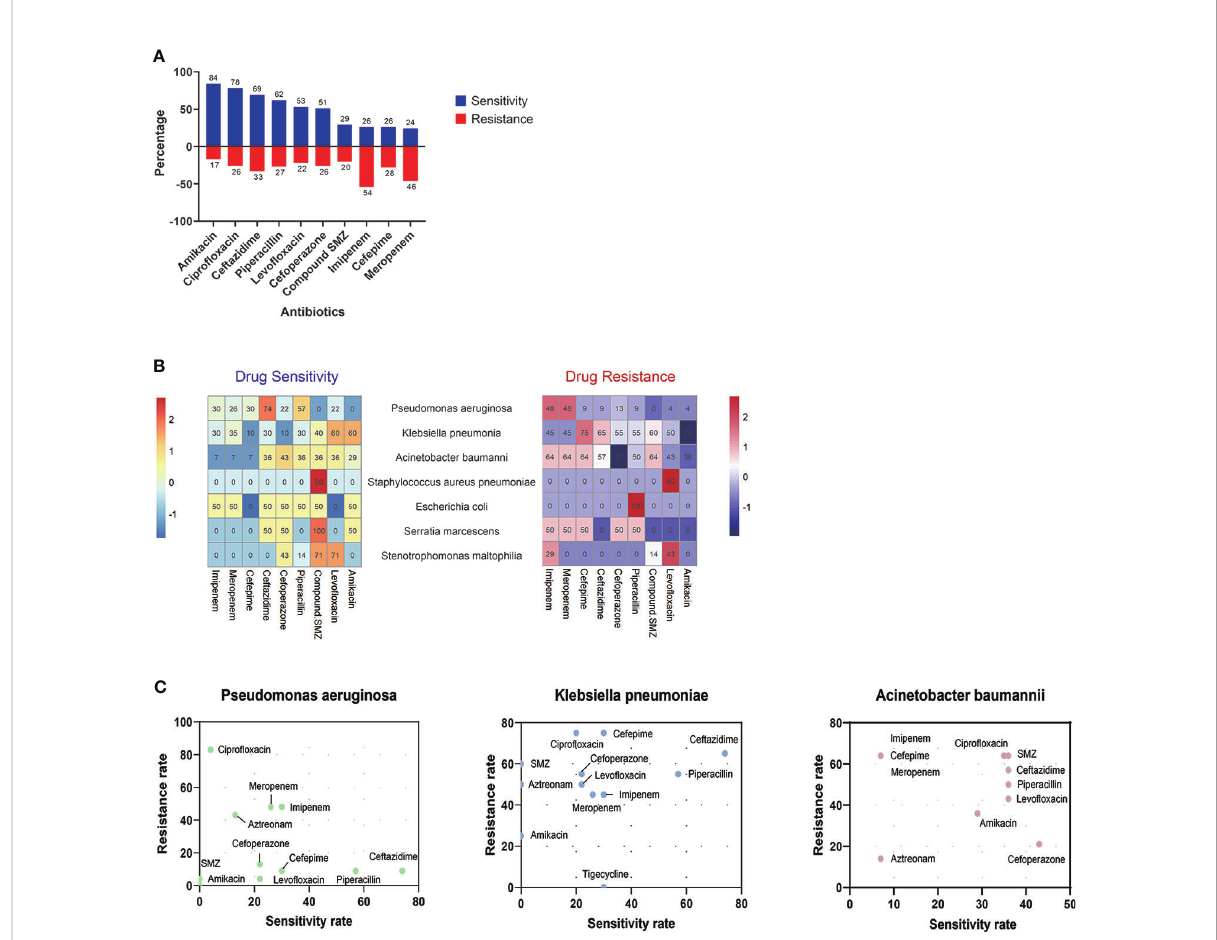
FIGURE 4 Drug resistance and sensitivity results of 112 bacteria. Amikacin (84/116, 72.41%) and cipro fl oxacin (78/116, 67.24%) had high-sensitivity rates among 10 antibiotics, while bacteria detected were highly resistant to imipenem (54/116, 48.27%) and meropenem (46/116, 39.66%) (A) . The results of antibiotic resistance and sensitivity in different drugs (B) and three main pathogens (C) are presented. SMZ,